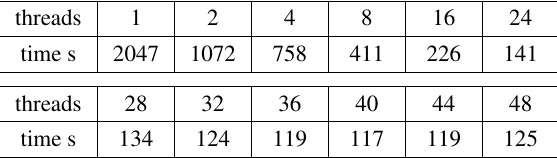
Table 2. Scalability of the CPU version of the interpolator for the Heligoland DSM with 60% valid pixels, n = 256 path directions